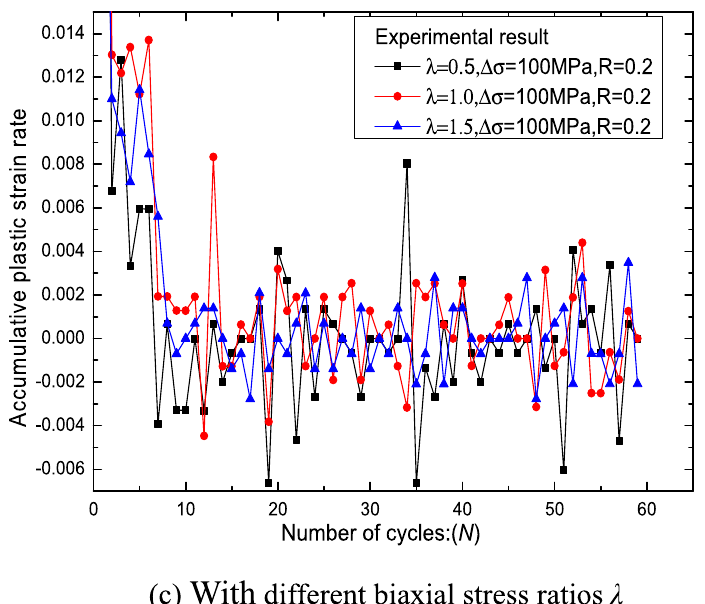
Fig. 9 Accumulation plastic strain rate for different biaxial